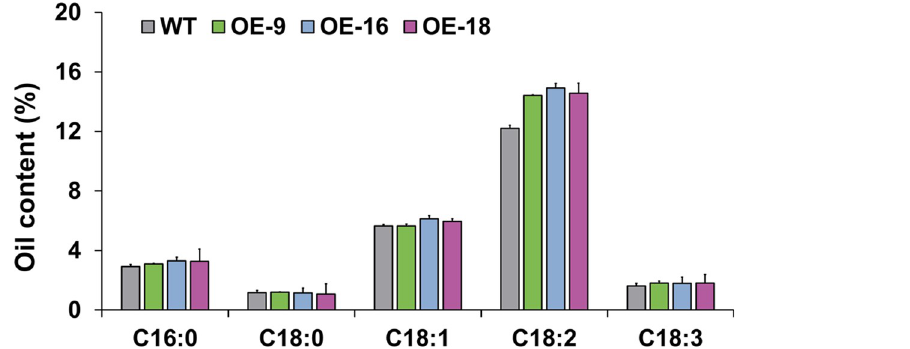
Fig 5. Comparison of fatty acid composition between OE and WT seeds.